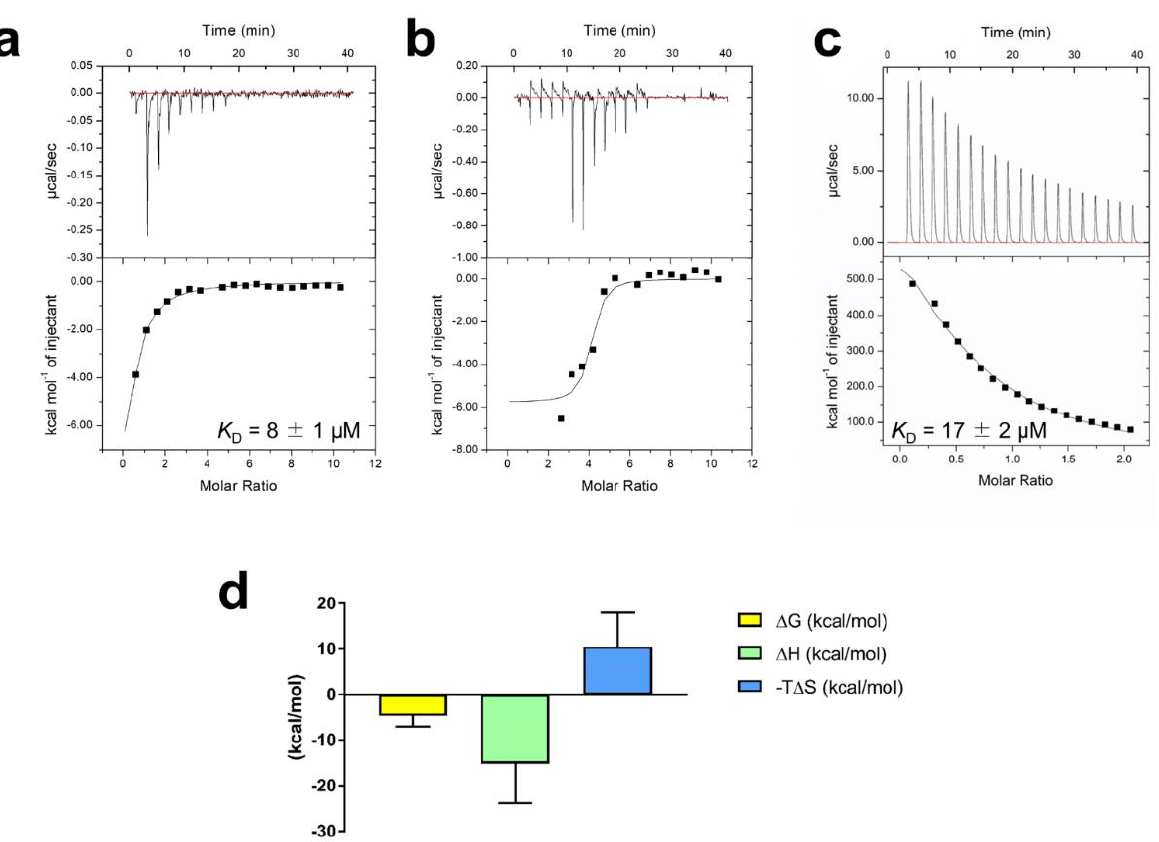
Figure 3. ITC analysis of RA binding to VmFbpA at 298 K. ( a ) Binding between 10 µ M apo VmFbpA and 500 µ M RA. ( b ) Binding between 10 µ M Fe 3+ -VmFbpA and 500 µ M RA. ( c ) Binding between 10 µ M apo VmFbpA and 100 µ M Fe 3+ . ( d ) Thermodynamic parameters for the binding of RA to apo VmFbpA calculated according to the data in ( a ). The free energy of binding ( ∆ G , light yellow bar) is the sum of the enthalpic ( ∆ H , light green bar) and entropic ( − T ∆ S , light blue bar) terms.